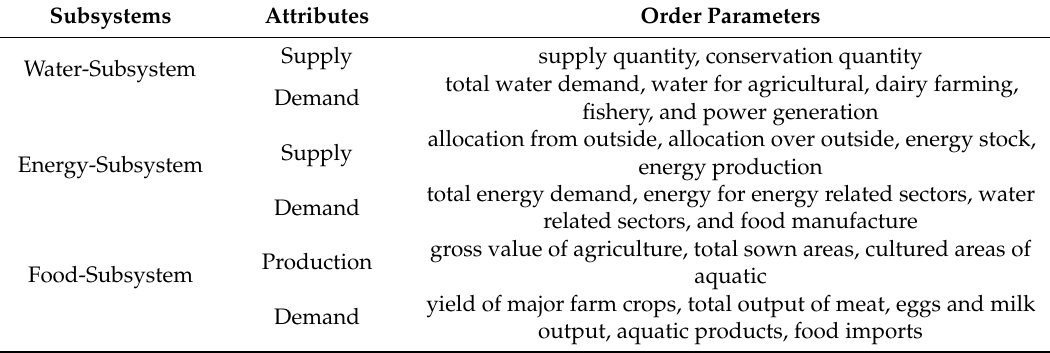
Table 1. Water, energy, and food (WEF)-Nexus subsystems, attributes, and order